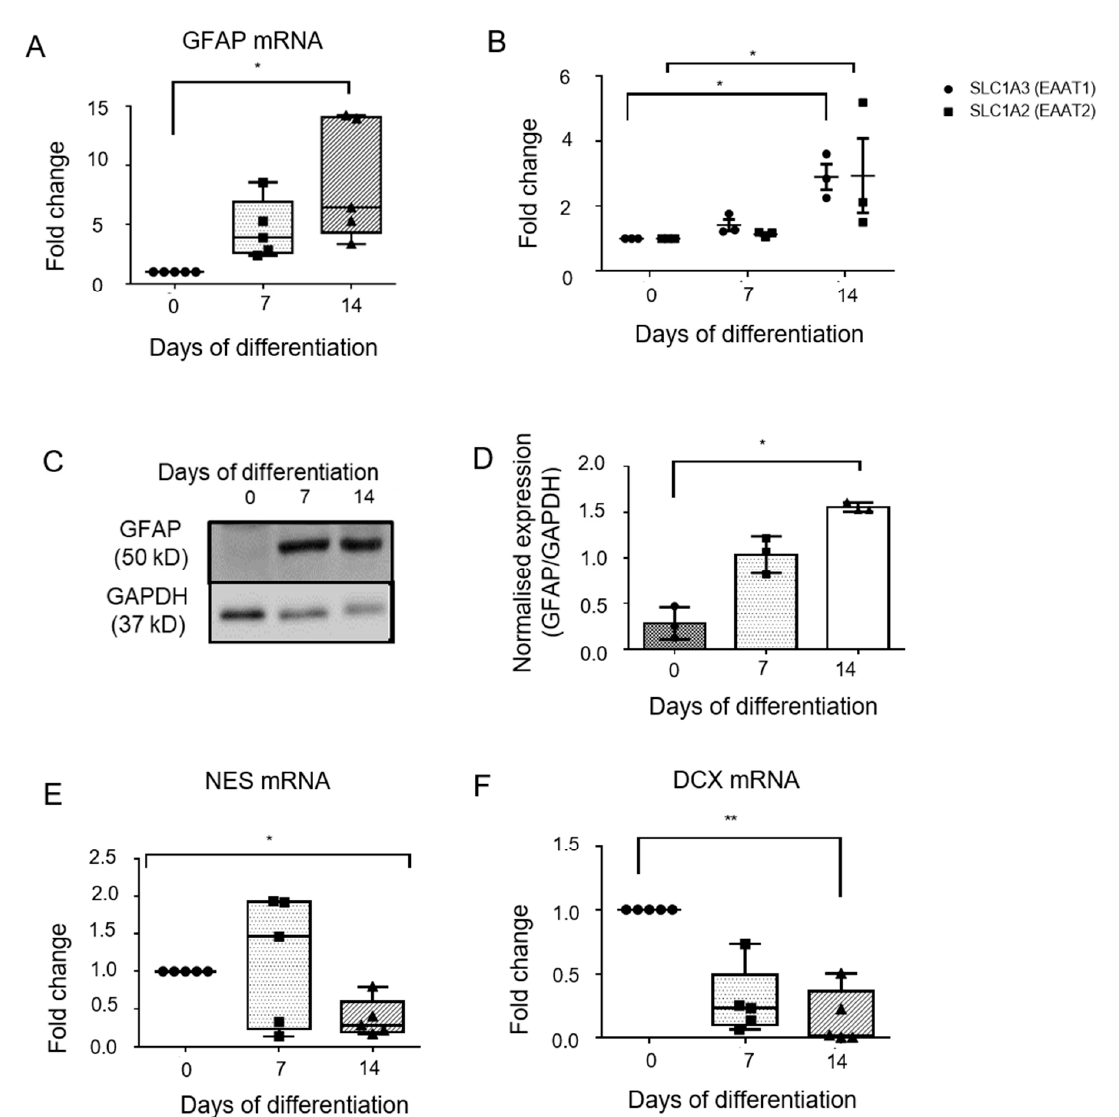
Figure 2 . Expression of lineage markers during differentiation of human FNSCs into astrocytes. Expression of astrocytic marker ( A ) glial fibrillary acidic protein (GFAP) (n = 5), ( B ) Excitatory amino acid transporters SLC1A3 (EAAT1) and SLC1A2 (EAAT2) (n = 3) mRNA expression at various days of differentiation as obtained on qPCR analysis. ( C ) Representative western blot image showing protein expression of GFAP at various days of differentiation. Glyceraldehyde 3-phosphate dehydrogenase (GAPDH) is loading control. ( D ) Quantification of western blot data (n = 3). mRNA expression of neural stem cell marker NES (Nestin) ( E ) and neuronal marker DCX (Doublecortin) ( F ) at various days of differentiation as obtained on qPCR analysis (n = 5). qPCR data is represented as fold change in gene expression obtained using day 0 samples as control. Data represented as Mean ± SD. * p -value < 0.05, ** p -value < 0.01.